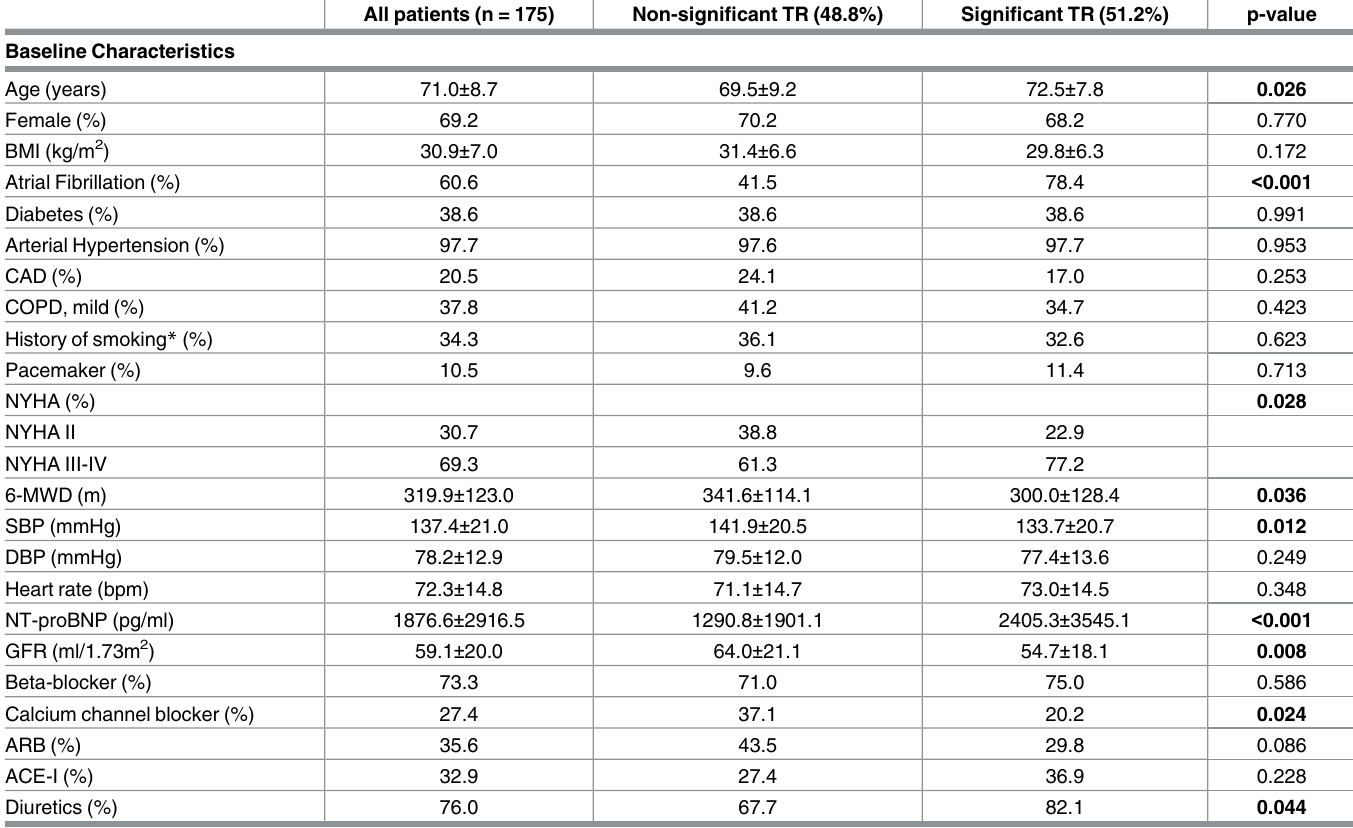
Table 4. Baseline clinical characteristics of HFpEF patients, stratified by tricuspid regurgitation severity. All patients (n = 175) Non-significant TR